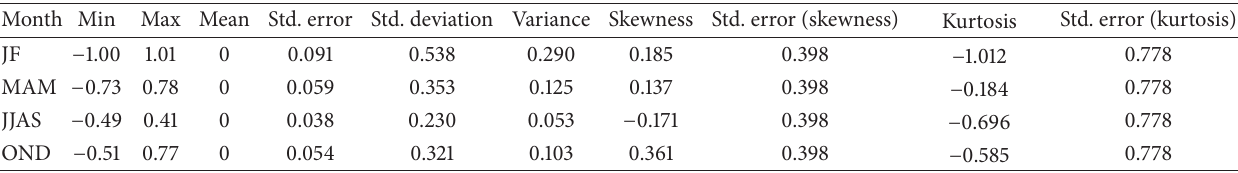
Table 5: General statistics of temperature at 700 hPa.